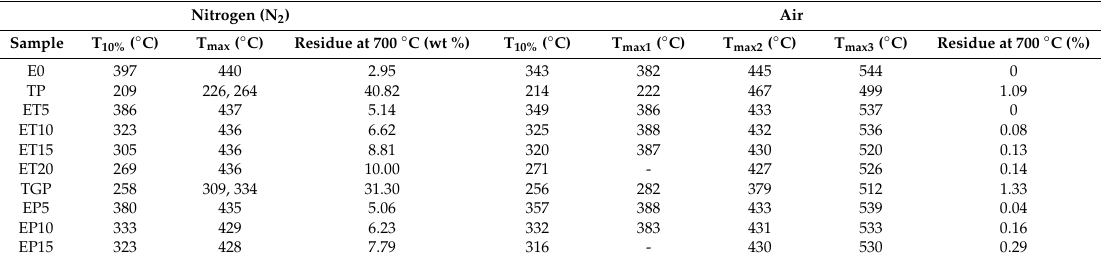
Table 2. Gathered values of T 10% , T max and the percentage of the residue at 700 °C obtained from thermogravimetric analysis for neat Ebecryl resin, ET and EP films.